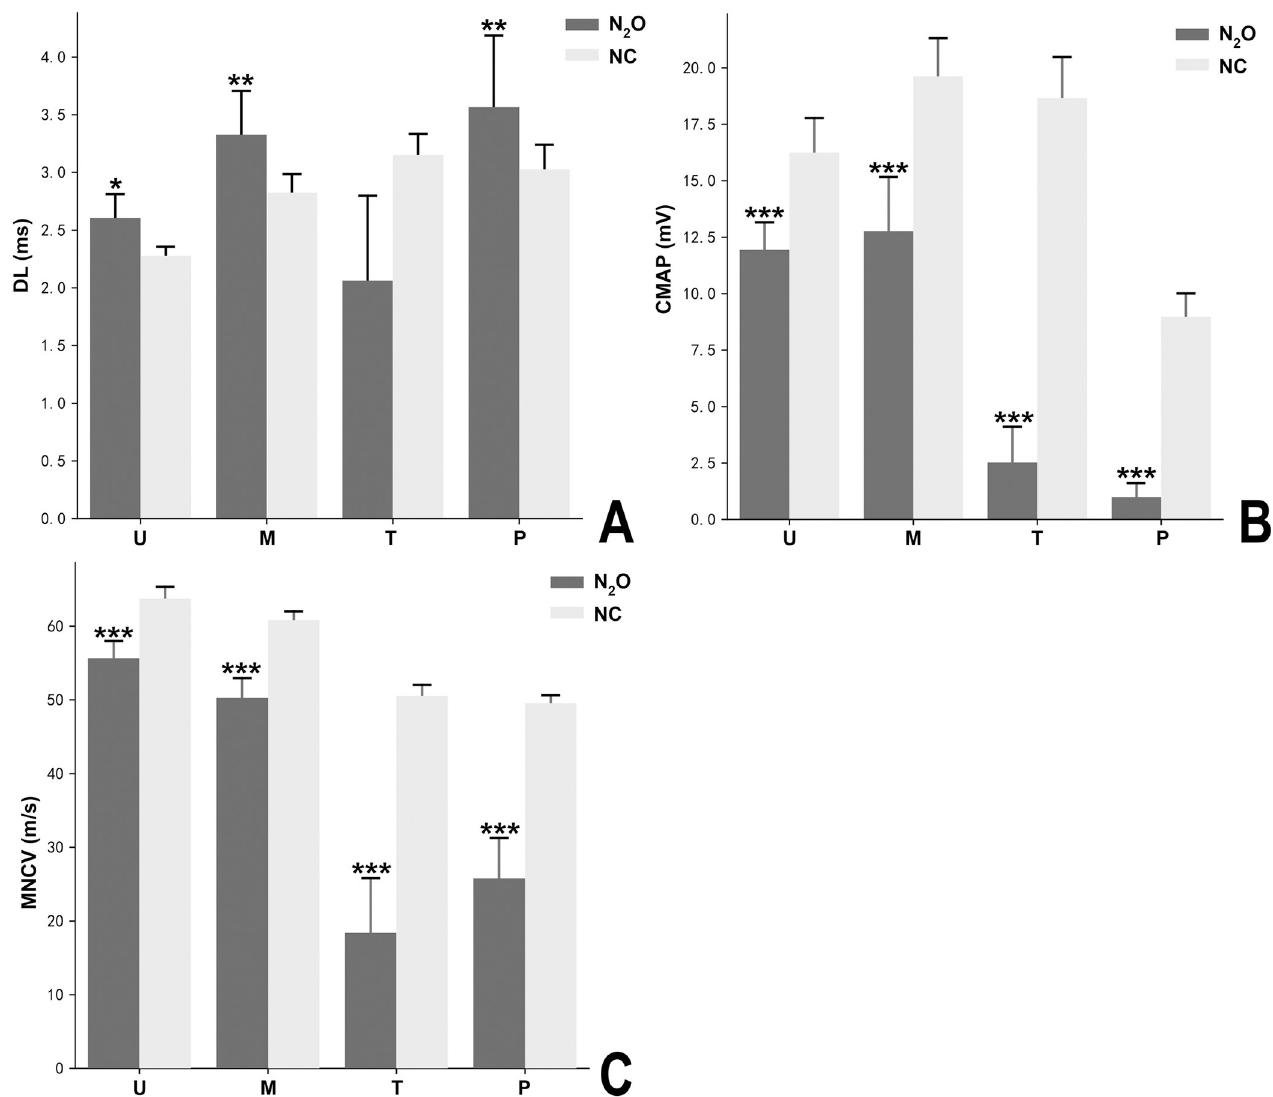
Fig 2. Motor nerve conduction study results in the normal control (NC) and N 2 O-induced neuropathy groups. (A) The compound muscle action potential amplitude, (B)motor conduction velocity, (C) distal latency of each motor nerve for the NC(N = 20, gray bar) and N 2 O-induced neuropathy groups (N = 18, black bar). Data are presented as mean ± standard error of the mean. Significant difference is indicated by ��� p < 0.001, �� p < 0.005, � P < 0.01 using Mann- Whitney U test. M, median nerve; U, ulnar nerve; P, peroneal nerve; T, tibial